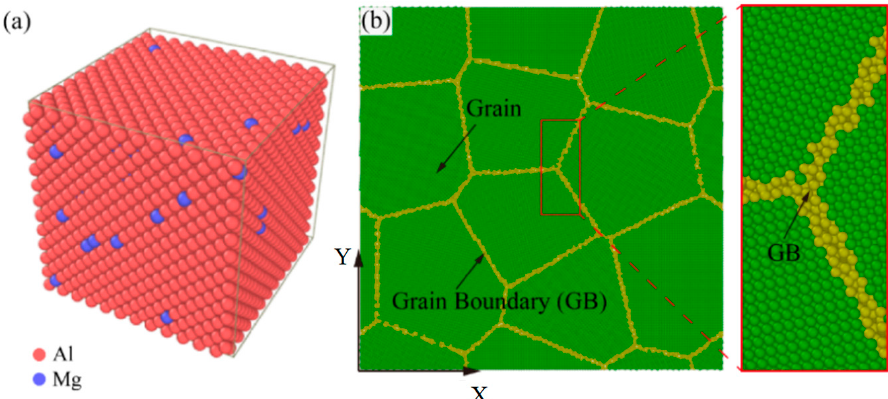
Figure 4. Molecular dynamics simulation models for Al-Mg alloys with 2% Mg content. ( a ) The single crystal Al-Mg alloy model. The red atoms denote the aluminum atom, and the blue atoms denote magnesium atom. ( b ) The polycrystalline Al-Mg alloy model with grain size d = 12.8 nm. The green atoms represent grain, and the yellow atoms represent GB.